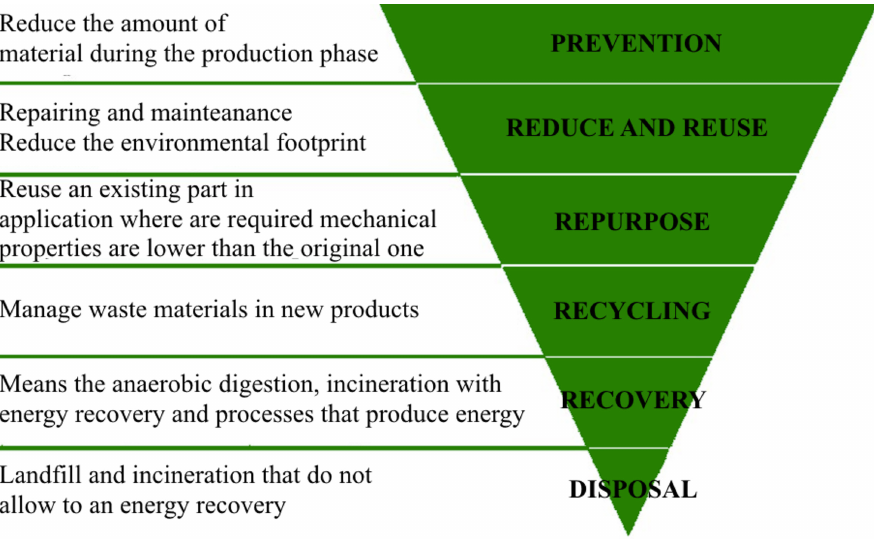
Figure 3. 2008/98/EC directive waste management hierarchy.